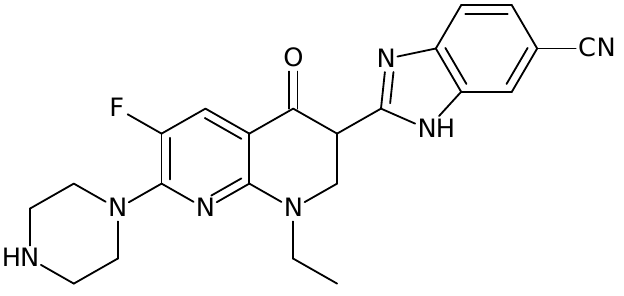
Figure 6. Chemical structure of LZ-106. LZ-106 induced apoptosis via activation of the ROS-dependent DNA damage response in NSCLC (non-small-cell lung cancer) in both cultured cells and in a xenograft mouse model. The authors demonstrated that LZ-106 notably induced ROS overproduction and DDR. Interestingly, additional evidence in their findings revealed that DDR and apoptosis could be alleviated in the presence of an ROS scavenger, N-acetyl- cysteine (NAC), indicating ROS-dependent DDR involvement in the LZ-106-induced apoptosis. This research not only offered a new therapeutic candidate for NSCLC, but also gave new insights into the pharmacological research of quinolones [69]. In 2019, Yang et al. continued to investigate the mechanism of the cytotoxic activity of LZ-106. They substantiated the involvement of P53 activation in intracellular ROS generation upon LZ-106 treatment and related P53 to the ROS-induced viability inhibition and apoptosis, which was presented in previous research. P53 was shown to play an indispensable role in the upregulation of intracellular ROS in LZ-106-treated NSCLC cells through ROS detection. The authors further identified the antiproliferation effect of LZ- 106 in NSCLC cells exhibited through G1 phase cell cycle arrest with a cell cycle analysis, with an expression analysis of the key proteins, and discovered that the cell cycle arrest effect is also mediated by the induction of ROS in a P53-dependent manner. In addition, the tumor-suppressive effect exhibited in vivo was demonstrated to be similar to that in vitro, which requires the participation of P53. Thus, LZ-106 is a potent antitumor drug